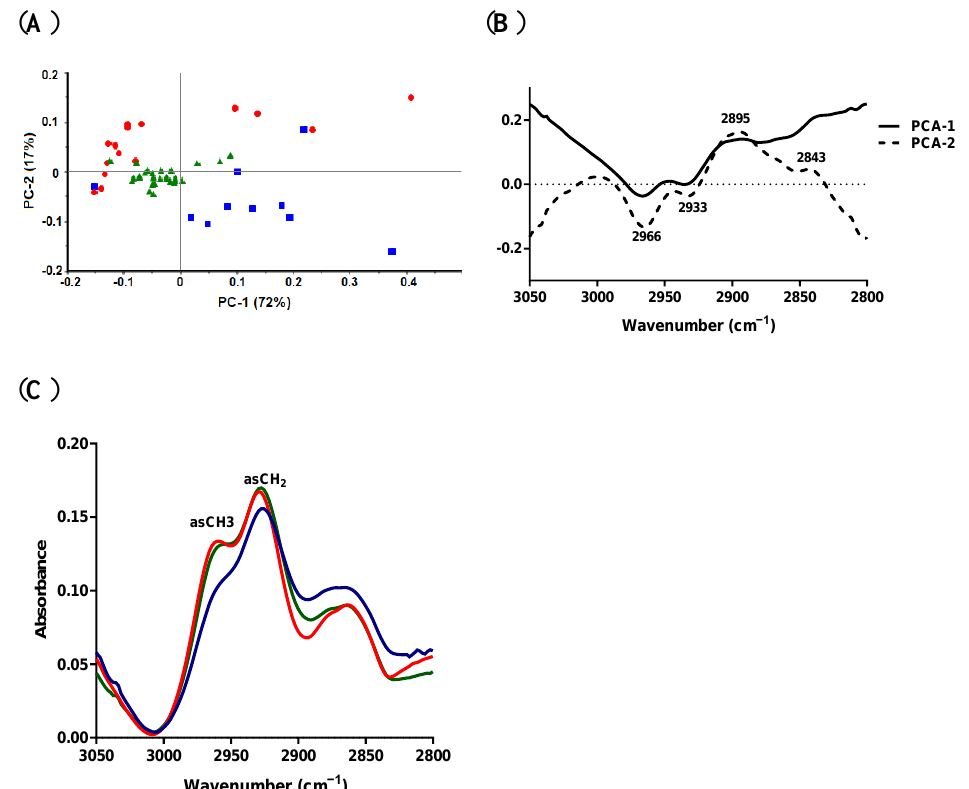
Figure 3. SR-FTIR spectra of lipid region from S. aureus wild type (SaW; red), combined natural SCV and hemB mutant (SCVhMu, green) and complemented mutant (SaCMu; blue). ( A ) PCA score plot. ( B ) Loading plot of PC-1 and PC-2 of PCA model. ( C ) Unit-vector-normalized average raw spectra.